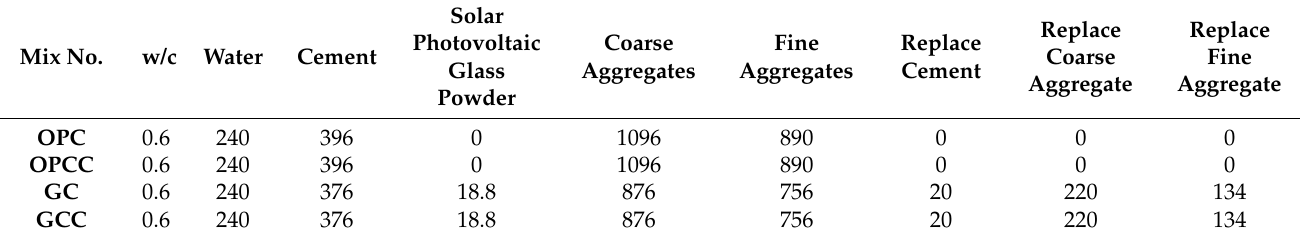
Table 12. Concrete mix design (kg/m 3 ).